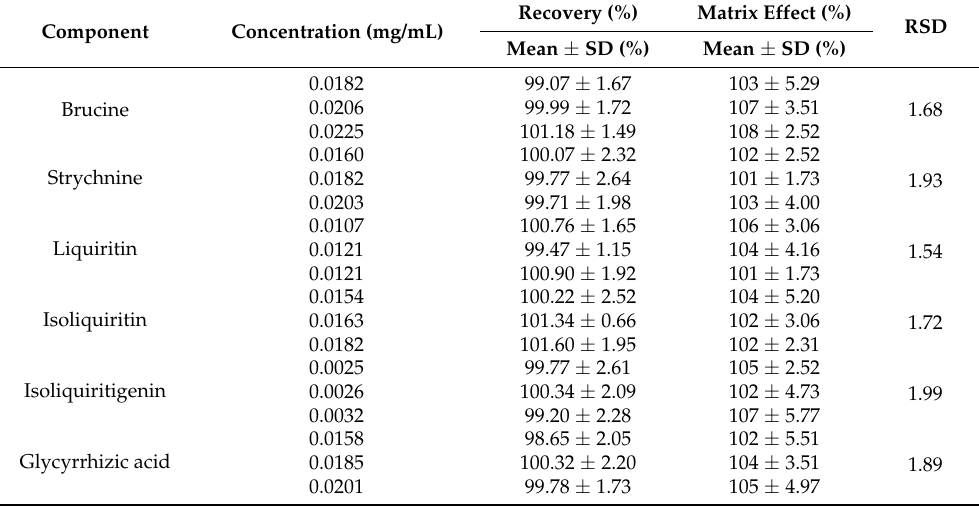
Table 2. Recovery and matrix effect of 6